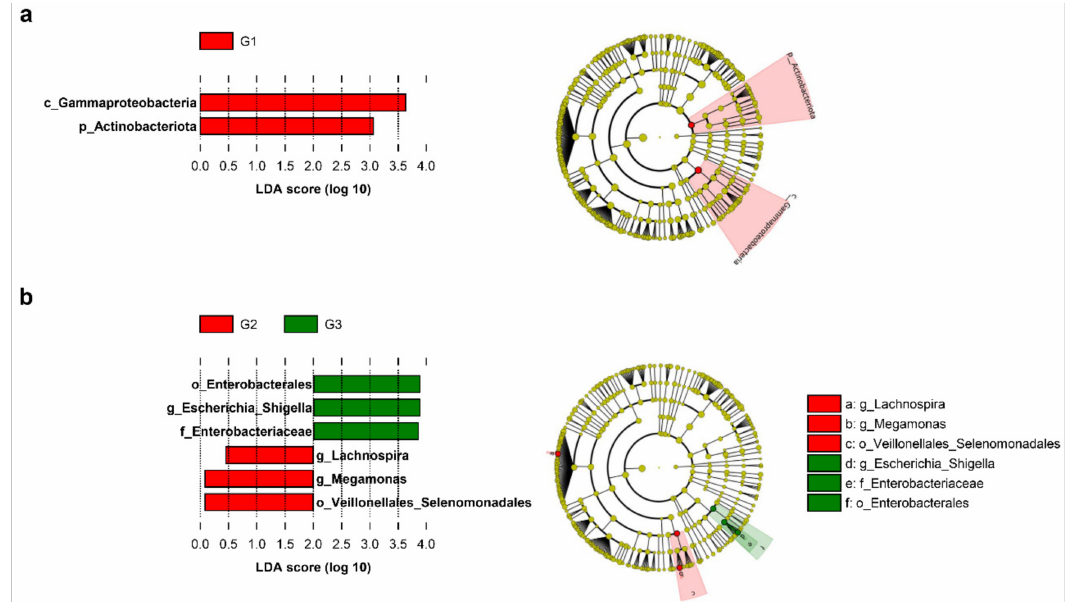
Figure 5. Linear discriminant analysis effect size (LEfSe) analysis of microbial abundance among PSA groups. A forest plot and Cladogram showing taxa that were significantly differentially abundant between ( a ) the G1 (red) and G2 (green) groups and ( b ) the G2 (red) and G3 (green) groups, respectively, as determined using the Kruskal–Wallis test. LDA score (effect size) indicating significant differences in bacterial taxa (LDA score >3.0; alpha value p < 0.05). Cladogram generated using the LEfSe method showing the phylogenetic distribution of microbes associated where taxonomic levels of phylum, class, and order are labeled, whereas the family and genus are abbreviated. Plots were depicted using the LEfSe of the Galaxy of the Huttenhower